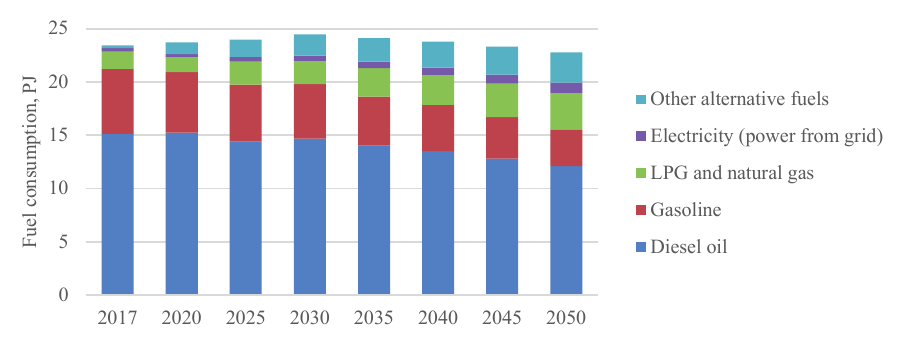
Fig. 9. Fuel consumption for land passenger transportation in the BASE scenario.